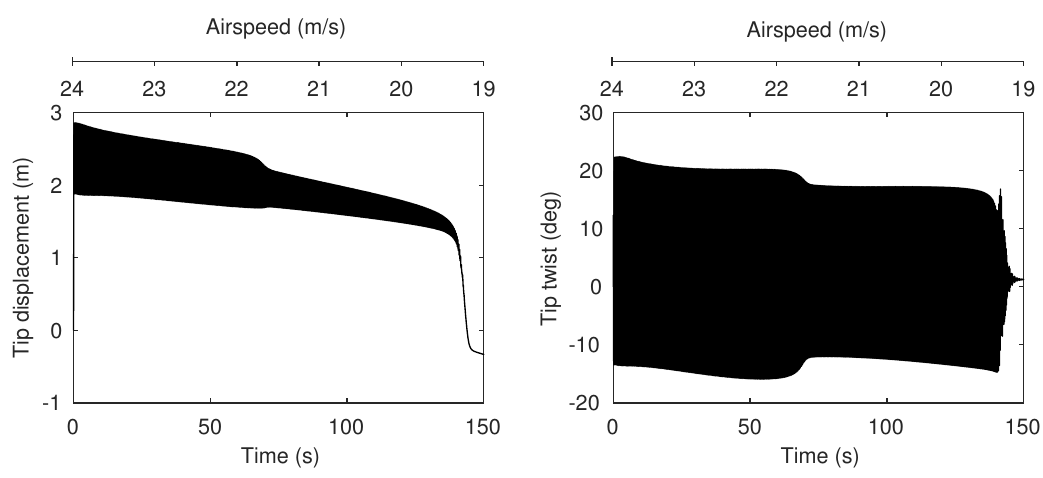
Figure 8. Time histories showing response to decreasing airspeed ramp (24 m/s–19